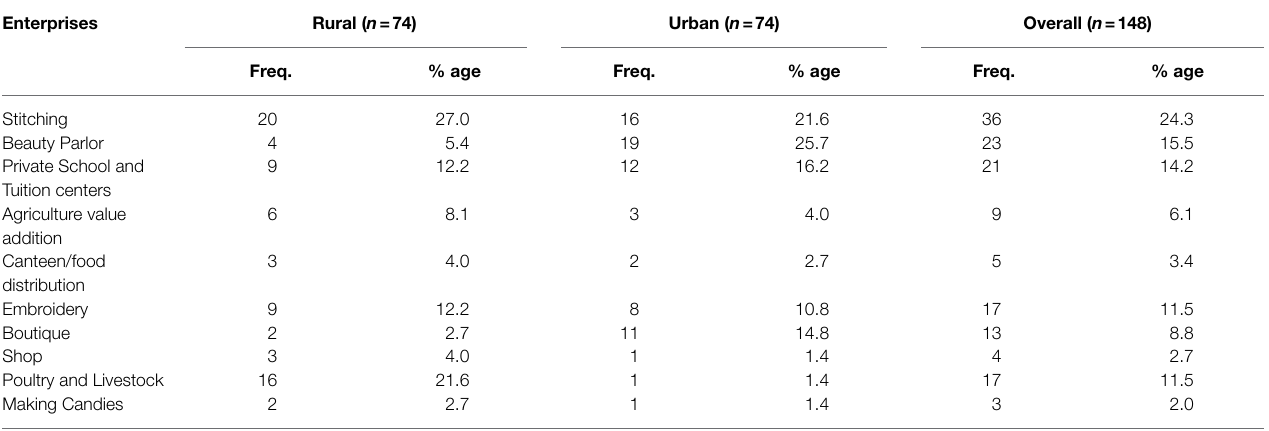
TABLE 1 | Distribution of sampled respondents in different